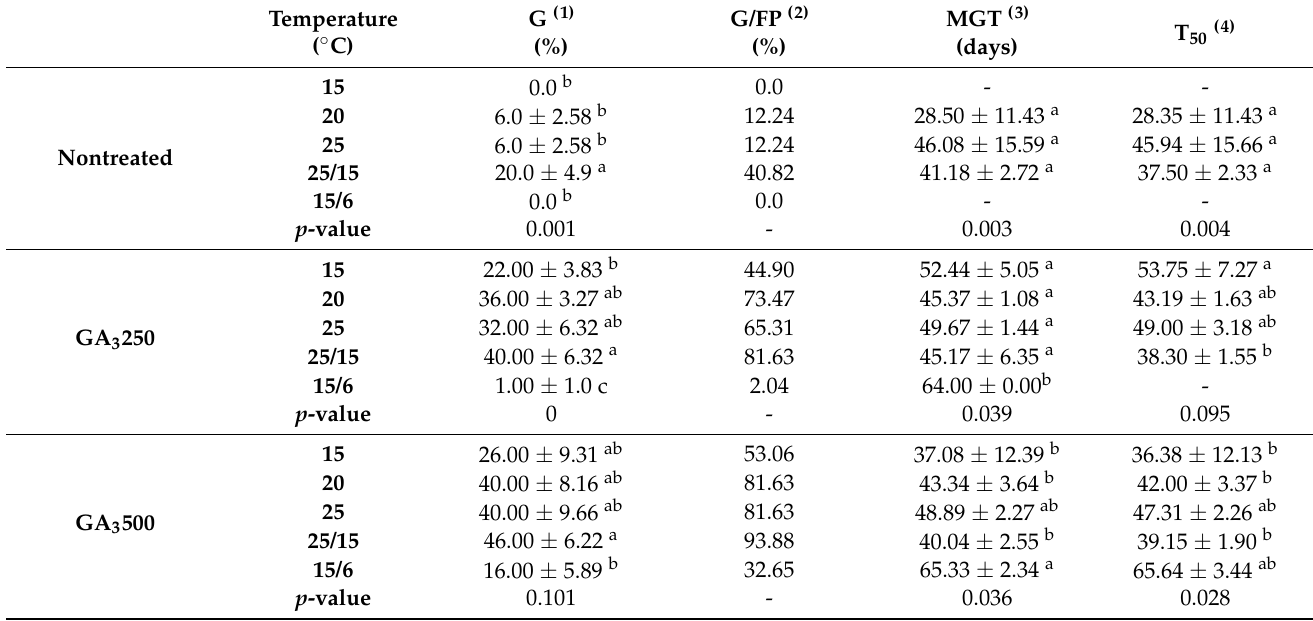
Table 2. Germination characteristics of Vaccinium oldhamii Miq. seeds under different germination temperature and Gibberellic acid (GA 3 )